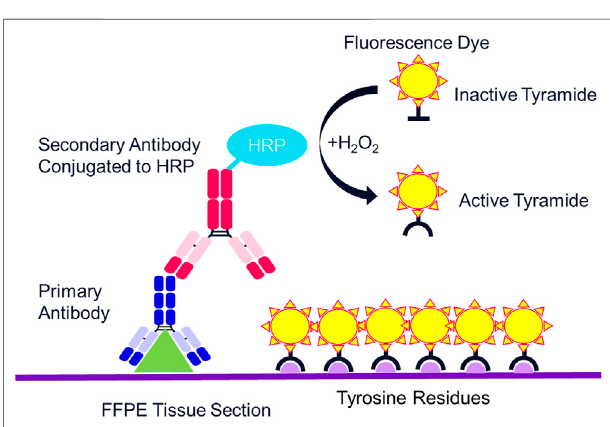
FIGURE 3 | Mechanism of tyramide signal ampli fi cation (TSA) staining. Opal dyes allow for the use of any standard unlabeled primary antibody, including multiple antibodies raised in the same species. After introduction of theprimaryantibody,theOpalpolymerHRPisapplied. TheOpalsystem uses TSA to amplify IHC detection by covalently depositing multiple fl uorophores near that targeted antigen. After labeling is complete, antibodies are removed in a manner that does not disrupt the Opal fl uorescence signal, allowing for the next target to be detected without antibody